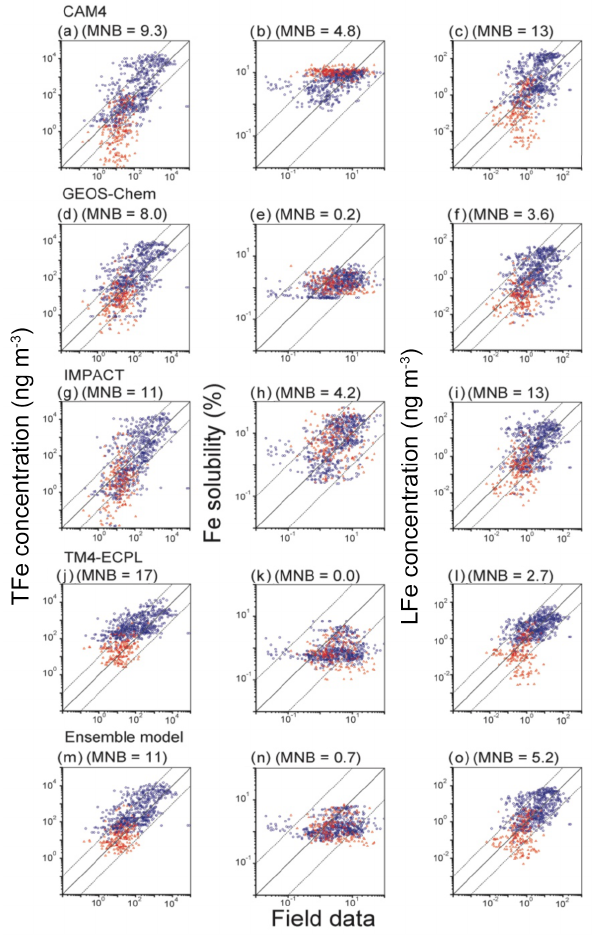
Figure 4. Comparison of simulated and observed TFe concentra- tions (ngm − 3 ), Fe solubility (%) and LFe concentrations (ngm − 3 ) in the Northern Hemisphere (blue circles) and Southern Hemisphere (red squares) for (a, b, c) CAM4, (d, e, f) GEOS-Chem, (g, h, i) IM- PACT, (j, k, l) TM4-ECPL, and (m, n, o) the ensemble model. The mean normalized biases (MNB) between the models and observa- tions are presented in parentheses. The solid line represents a 1 : 1 correspondence and the dashed lines show the 10 : 1 and 1 : 10 rela- tionships, respectively. The bias correction in the mineral dust size distribution is applied for the comparison with field data (Kok et al., 2017).